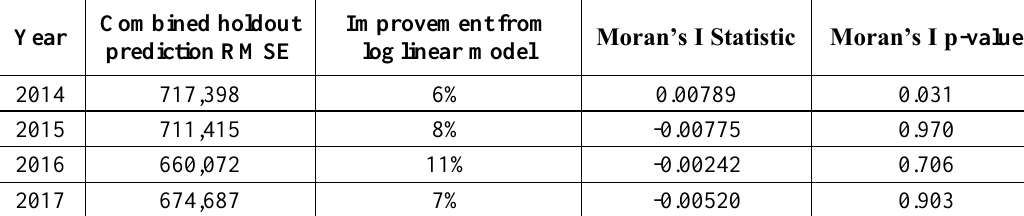
Table 9: GBM Combined Holdout Error